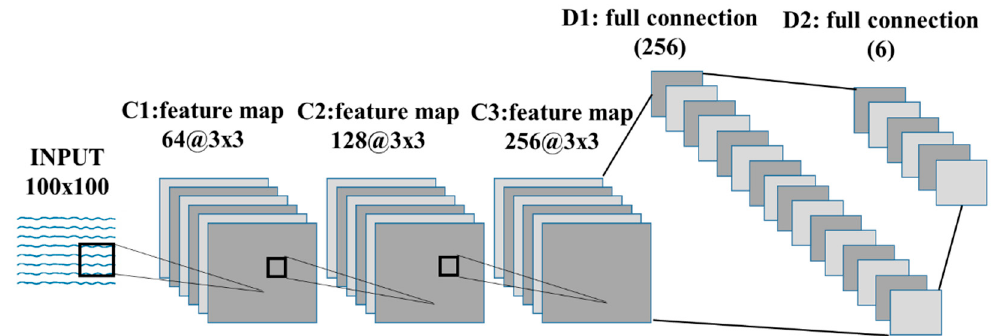
Figure 6. Deep learning architecture for anomaly detection.